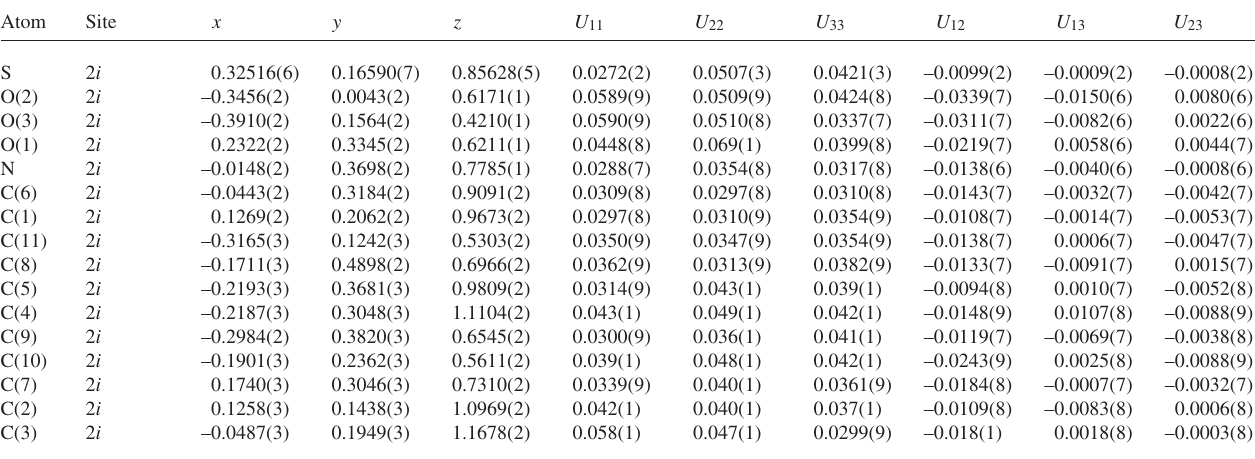
Table 3. Atomic coordinates and displacement parameters (in Å 2 )